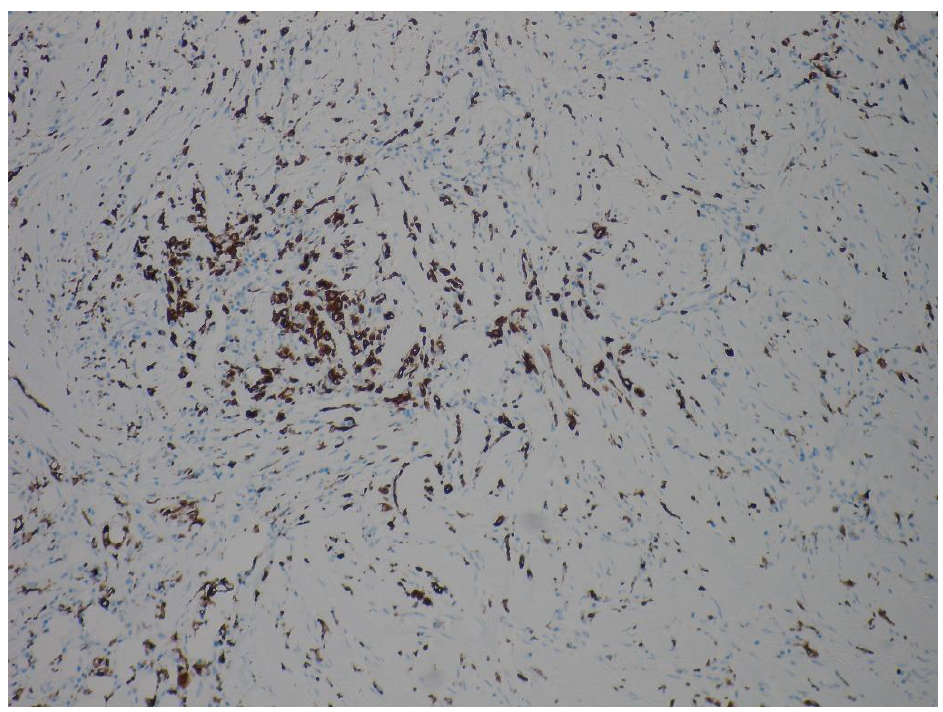
FIGURE 4. CD68-positive epithelioid and foamy macrophages were detected ( 